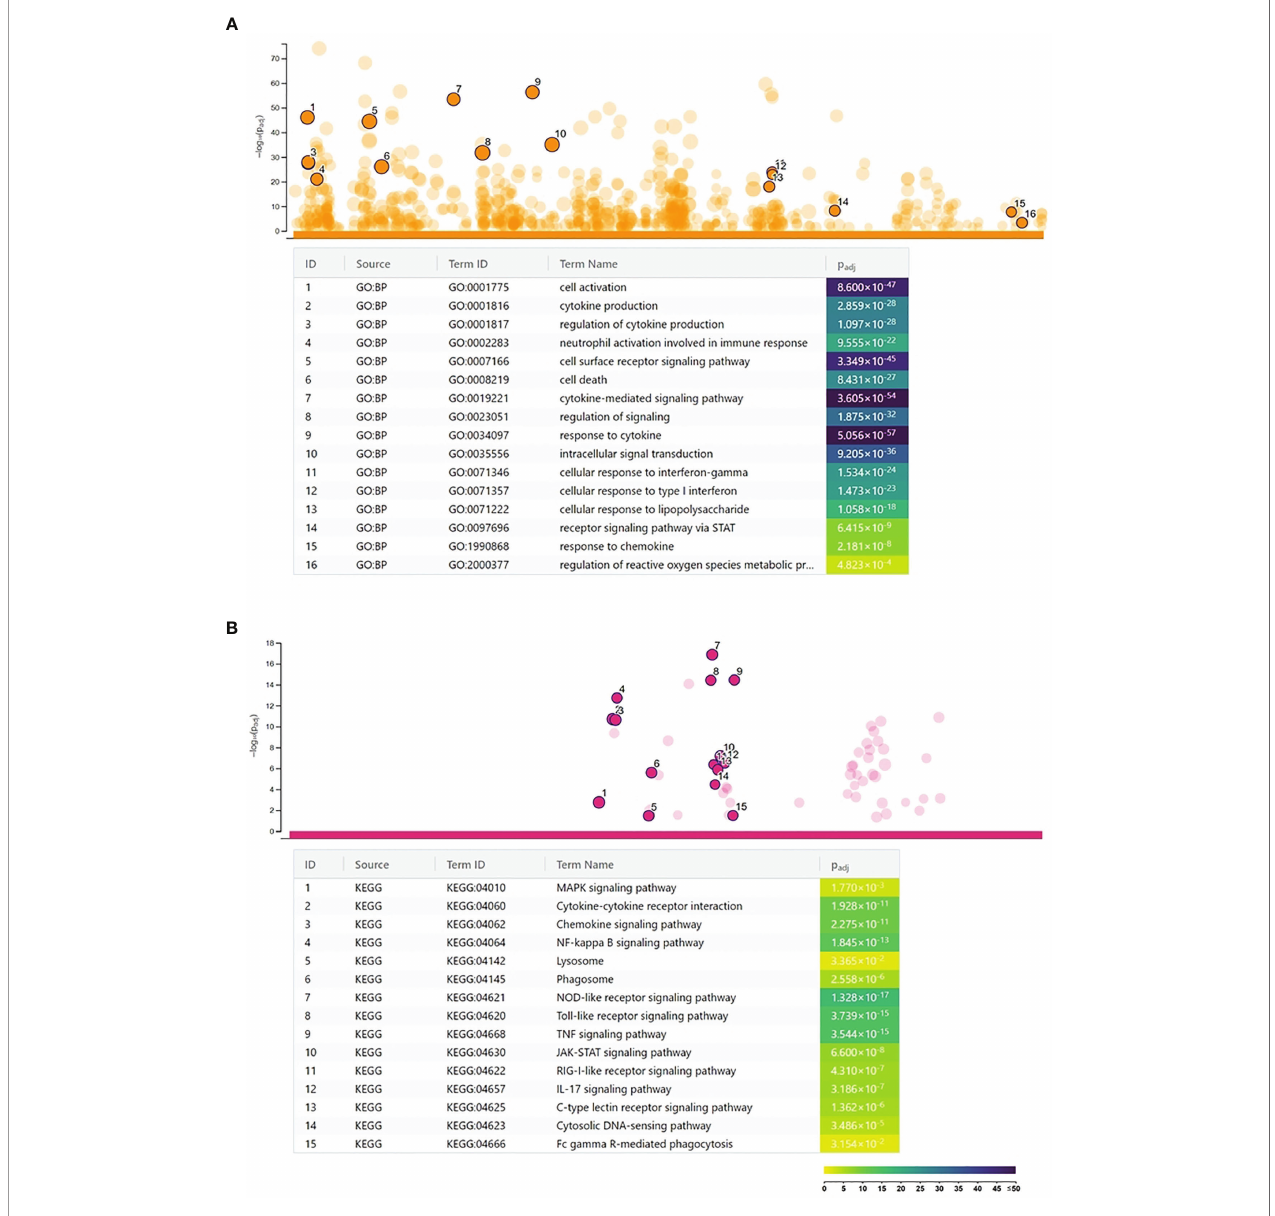
FIGURE 1 | Functional analysis of the Chlamydia trachomatis infection-induced genes. (A) Gene Ontology analysis of signi fi cantly enriched biological function terms containing differentially expressed genes. The names and signi fi cance levels of enrichment of selected functional category terms are shown. (B) Analysis of signi fi cantly enriched Kyoto Encyclopedia of Genes and Genomes pathways containing induced genes. The names and signi fi cance levels of enrichment of selected pathways are shown. The color coding of biological function and pathway term enrichment P -values denotes the signi fi cance level of enrichment. The color scale shows the – log 10 P -value of